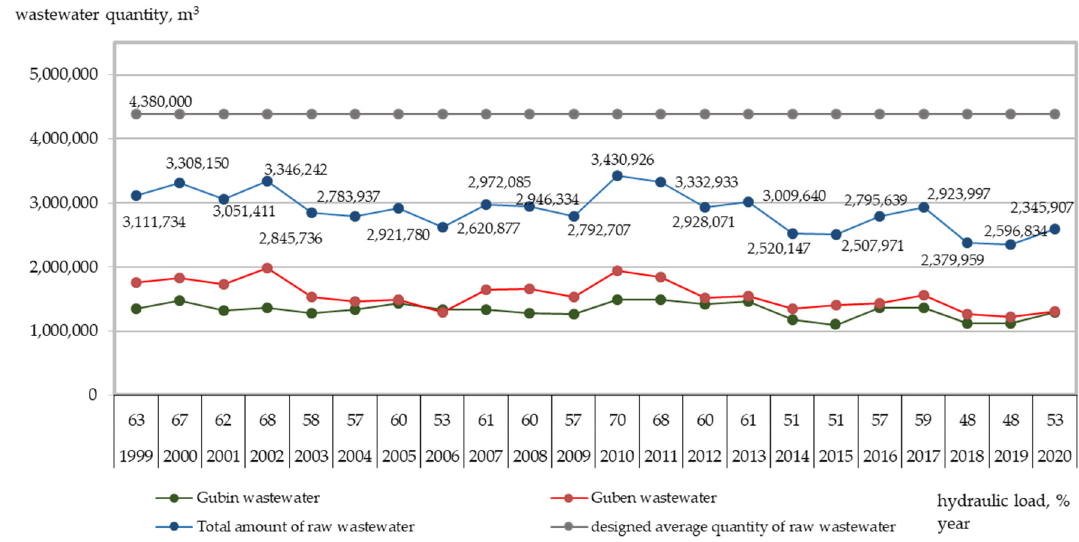
Figure 3. Quantity of raw wastewater inflowing to the Gubin–Guben WWTP in the years 1999–2020.